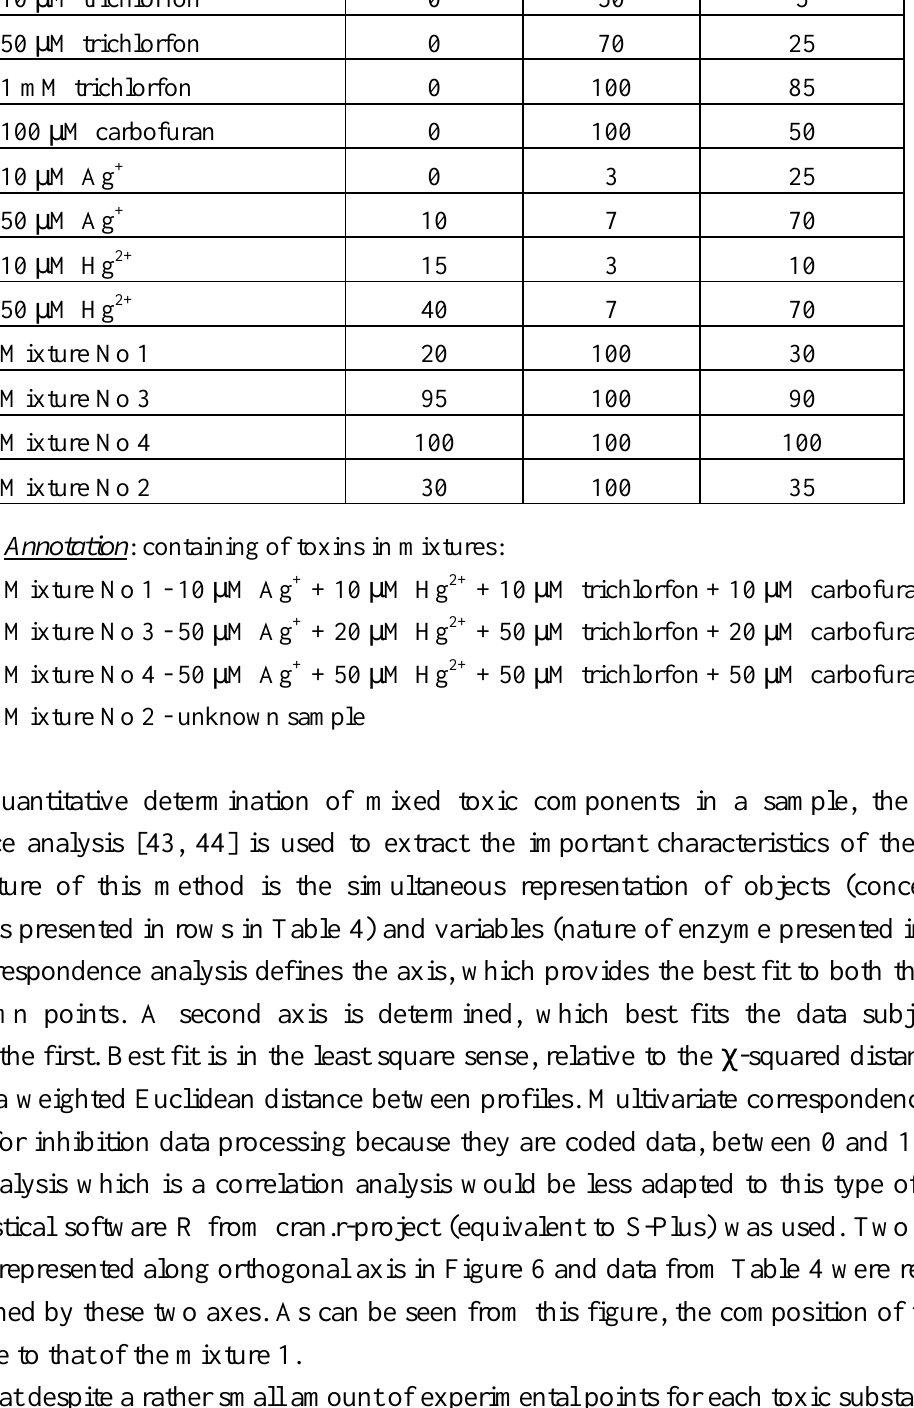
Table 4. Level of inhibition of enzymes by different toxic substances (%). Urease BuChE